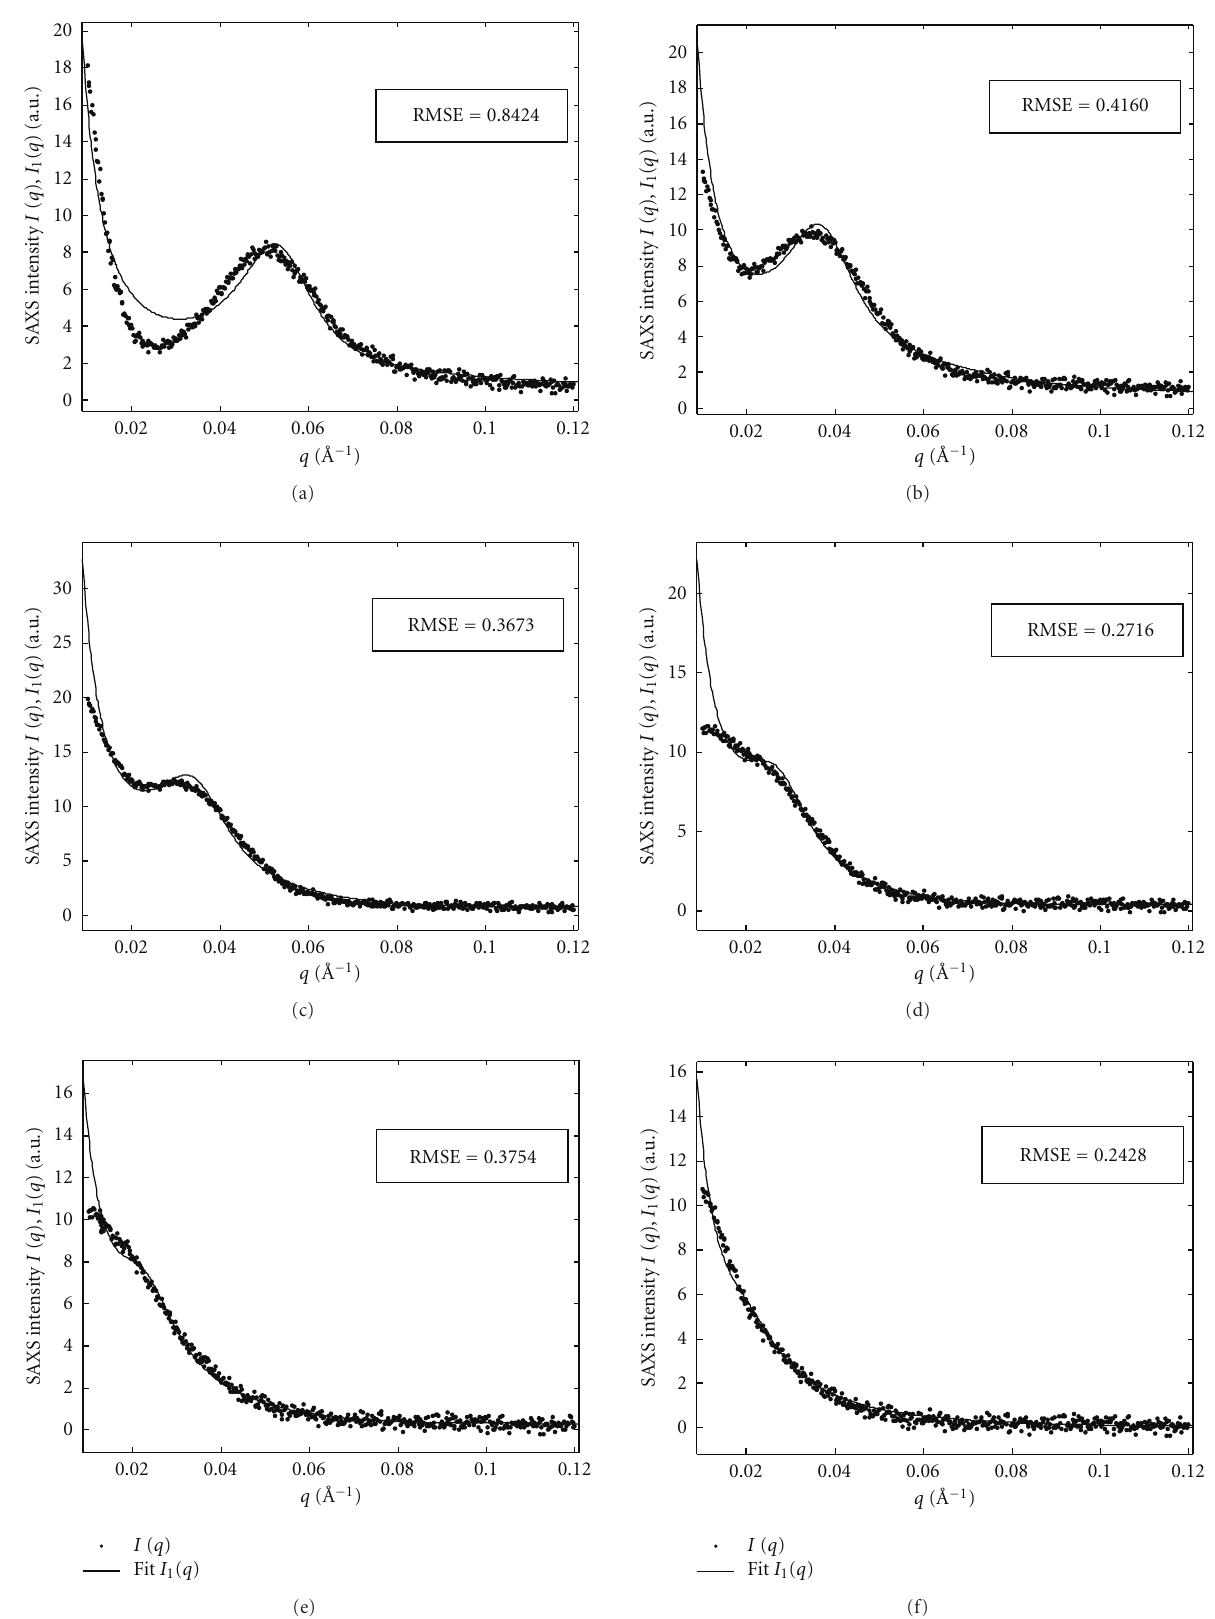
Figure 1: Best fit between theoretical I 1 ( q ) and experimental I ( q ) SAXS intensity profiles for (a) pure PVDF; (b) 90 wt% PVDF sample; (c) 80 wt% PVDF sample; (d) 70 wt% PVDF sample; (e) 60 wt% PVDF sample; (f) 50 wt% PVDF